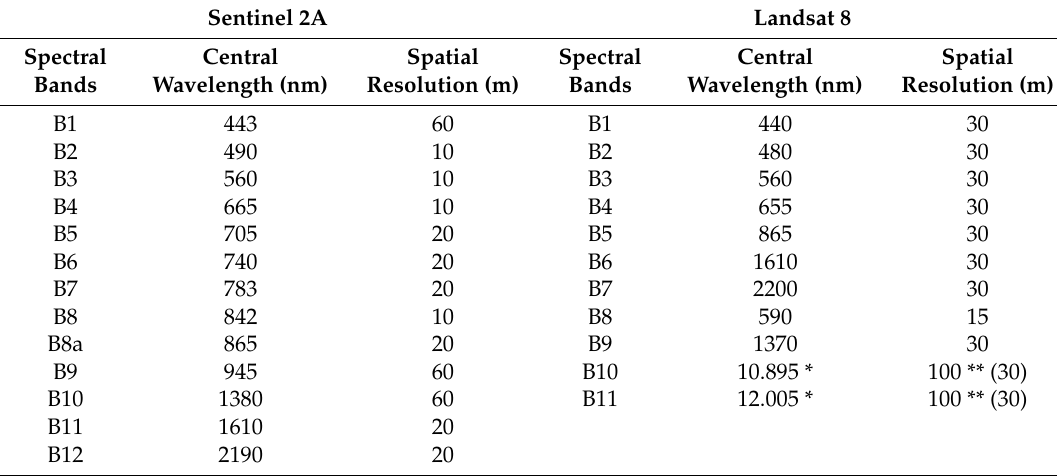
Table 1. Main characteristics of Sentinel 2A and Landsat 8.